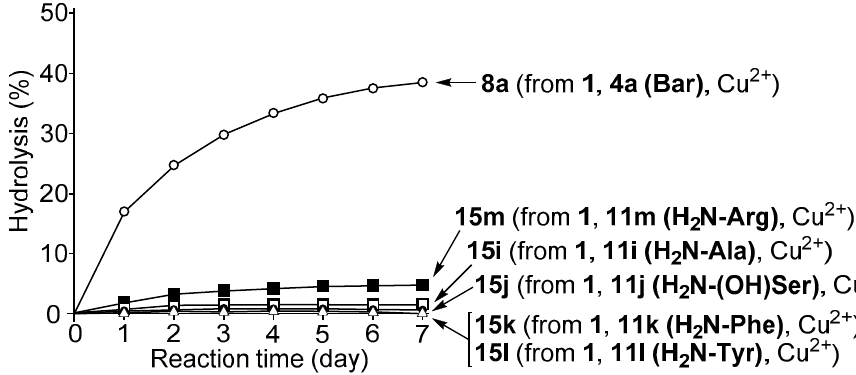
Figure 3. Hydrolysis of MNP (100 μ M in the total solution) by 8a (open circles), 15i (open squares), 15j (closed circles), 15k (open triangles), 15l (open triangles), or 15m (closed squares) ([ 8 or 15 ] = 100 μ M) in a single aqueous phase (10 mM HEPES buffer (pH 7.4) with I = 0.1 (NaNO 3 )) at 37 °C.